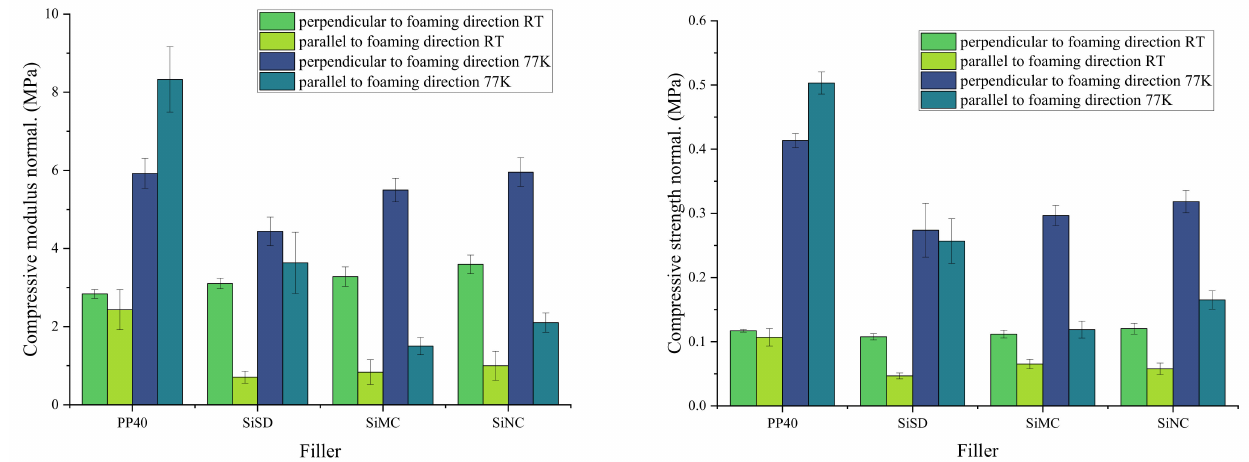
Figure 11. Compressive modulus ( left ) and strength ( right ) of neat PP40 and PP40 composites with 1.5% filler concentration. As depicted in Figure 11 (left), the compressive modulus of PP40 composites in a perpendicular direction at RT was slightly higher than for neat PP40, but other properties were lower than for neat PP40 at RT. Compressive strength (see Figure 12 (right)) of PP40 composites with 1.5% filler concentration was lower than for neat PP40. At 77 K, the stiffness of foams increased. Thus both compressive modulus and strength were